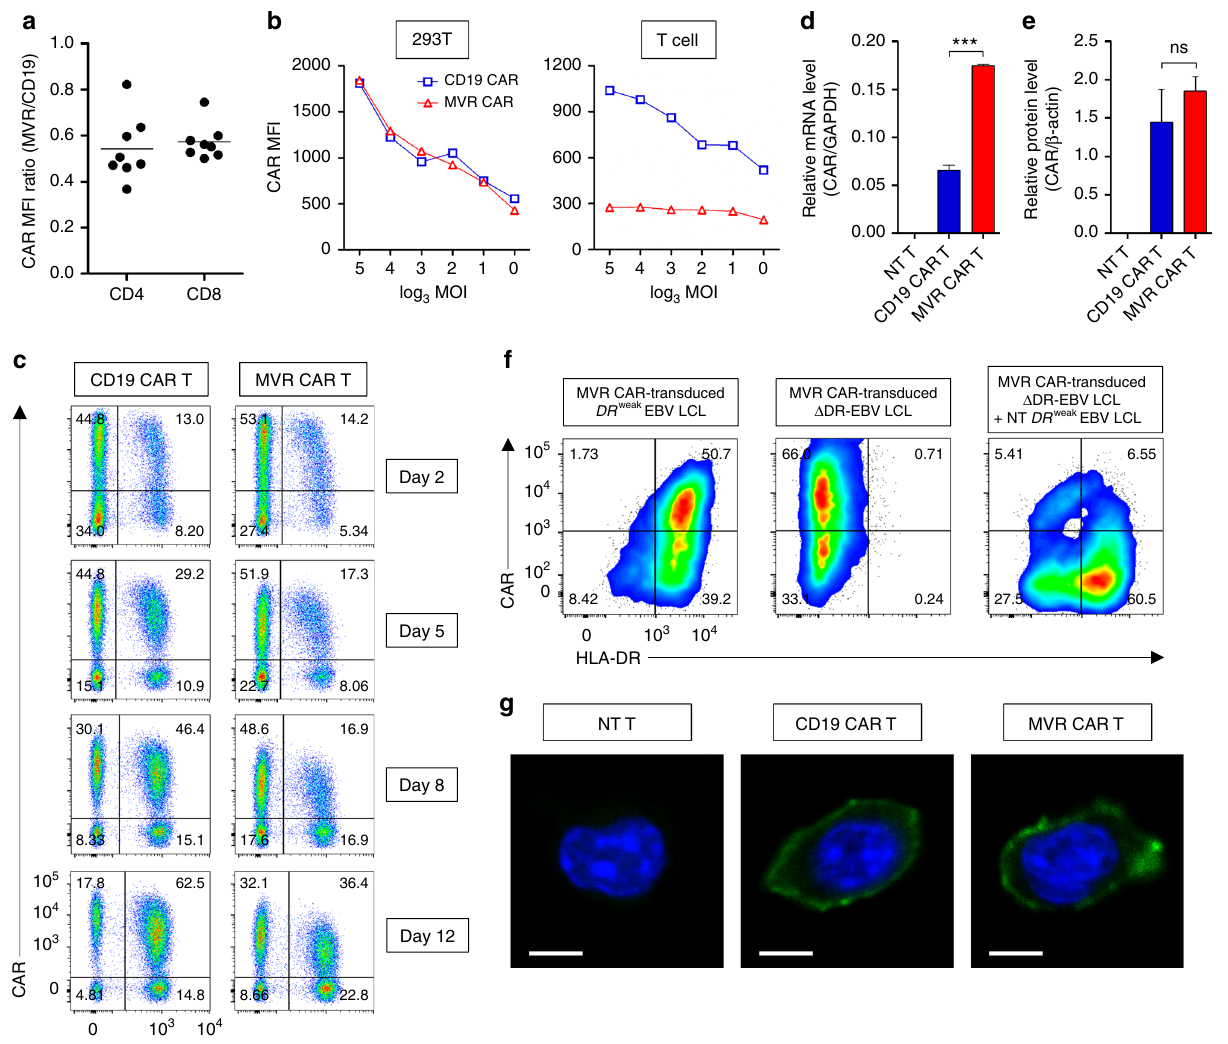
Fig. 2 Weak MVR CAR – HLA-DR interaction downregulates surface CAR in MVR CAR T cells. Cells from donors with HLA-DRB1 alleles exhibiting weak binding with MVR ( DR weak ; Fig. 1a) were used in the following experiments. a Differences in surface CAR expression between CD19 CAR T and MVR CAR T cells. The mean fl uorescence intensity (MFI) of the CAR expressed by DR weak MVR CAR T cells was divided by that of CD19 CAR T cells. CD4 + or CD8 + T cells were analyzed separately. Flow cytometric data from separately generated CAR T cell preparations was used ( n = 8). Horizontal lines indicate mean. b Lentivirus titer-dependent changes in expression of surface CAR. 293T cells and DR weak T cells were transduced with each CAR vector at various multiplicities of infection, and analyzed for MFI of CAR by fl ow cytometry. 293T cell lines and DR weak T cells were analyzed at 5 and 13 days post- transduction, respectively. c DR weak T cells transduced with the CD19 CAR or MVR CAR vector were analyzed for CAR expression at the indicated times post-transduction. Cells were analyzed for CD8 and CAR expression. d , e CAR expression analyzed at the mRNA ( d ) and protein ( e ) levels by qPCR and western blotting, respectively. Non-transduced (NT) T, CD19 CAR T, and DR weak MVR CAR T cells were subjected to CD4-negative sorting to enrich for CD8 + T cells using CD4 microbeads (130-045-101, Miltenyi Biotec, Inc.) and used for analysis. f CAR downregulation in MVR CAR-transduced EBV LCLs; transduced DR weak EBV LCLs (left); transduced HLA-DR-defective ( Δ DR)-EBV LCLs (center); transduced Δ DR-EBV LCLs co-cultured with non-transduced DR weak EBV LCLs for 2 days (right). Cells were analyzed for HLA-DR and CAR expression. g Immuno fl uorescence staining of NT T, CD19 CAR T, and DR weak MVR CAR T cells. Representative images from Supplementary Fig. 3 (scale bar = 5 μ m). a Summary of eight independent experiments. b – d , f Representative of two independent experiments. d , e n = 3 biological replicates. Mean ± s.e.m. Unpaired two-tailed t -test: ns not signi fi cant; ***, p <